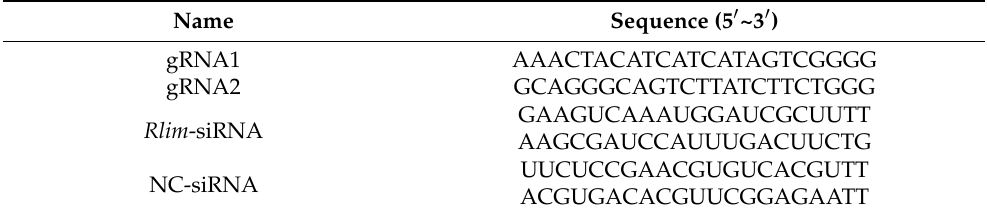
Table 1. Sequences of gRNAs, Rlim -siRNA and NC-siRNA used in this study.